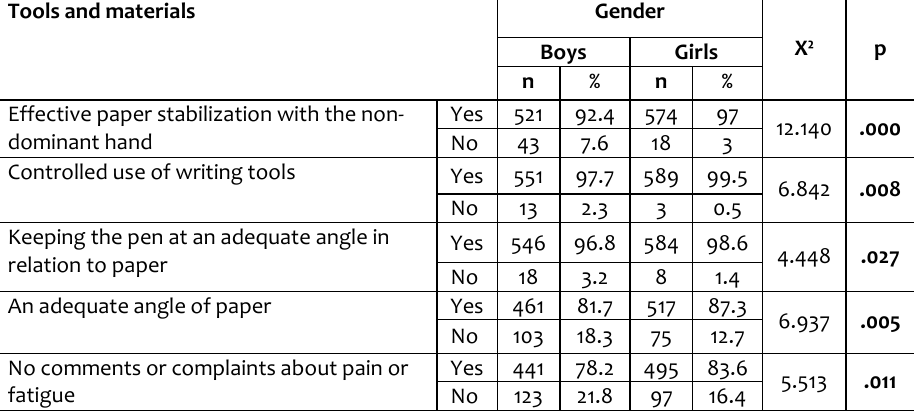
Table 3. Use of tools and material of boys and